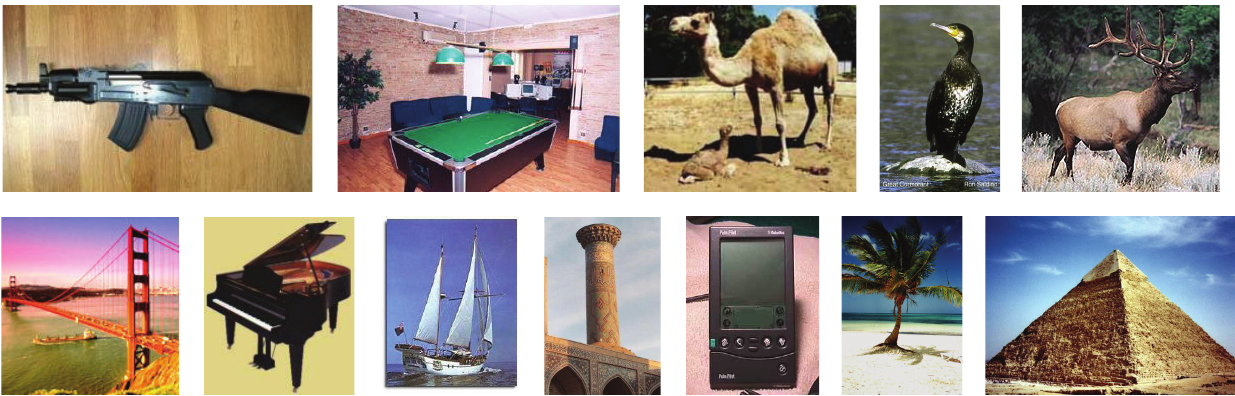
Figure 8: Example images of the Caltech-256 dataset.